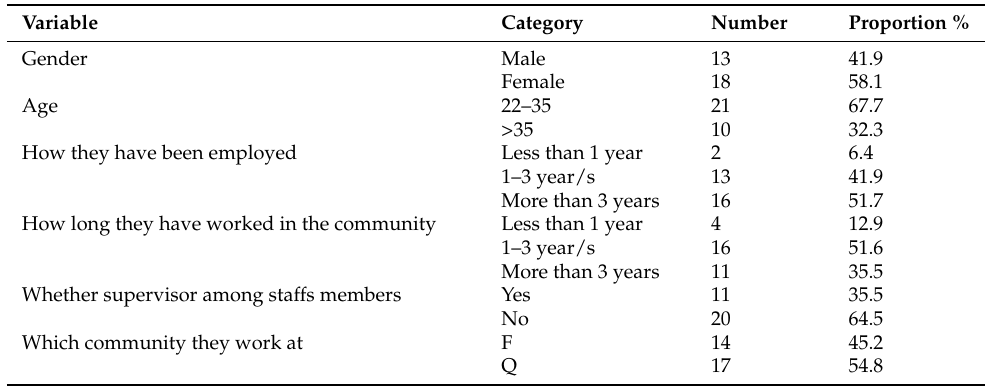
Table 2. Sociodemographic information for staff member